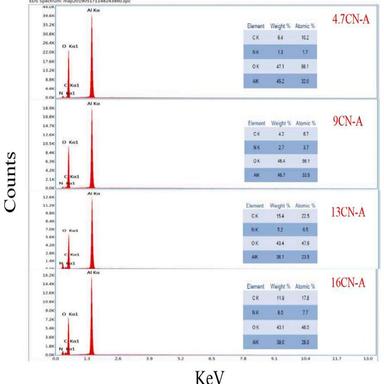
EDAX data of CN-A samples with various loadings: (a) 4.7CN-A; (b) 9CN-A; (c) 13 CN-A; (d) 16CN-A.